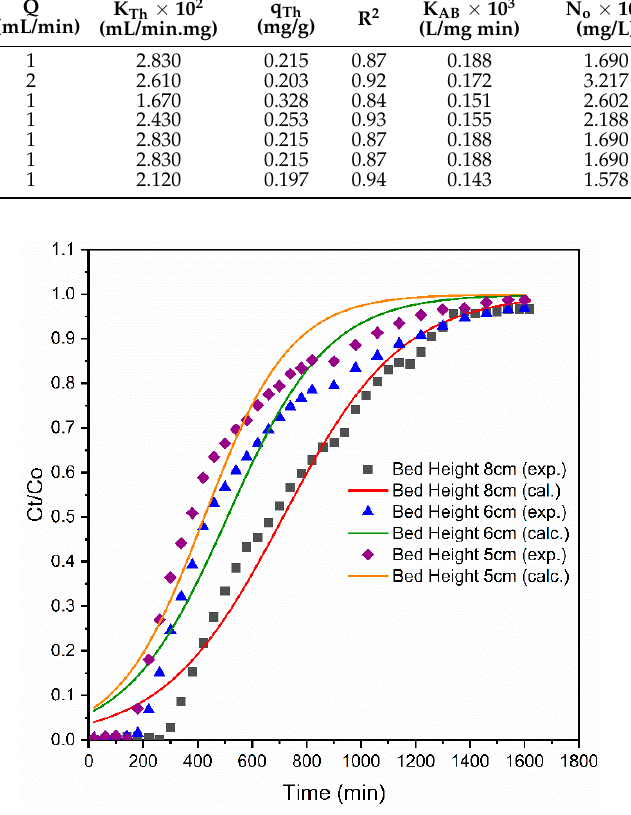
Figure 6. Experimental and calculated breakthrough curve for Adams–Bohart model at different values of adsorbent bed height.